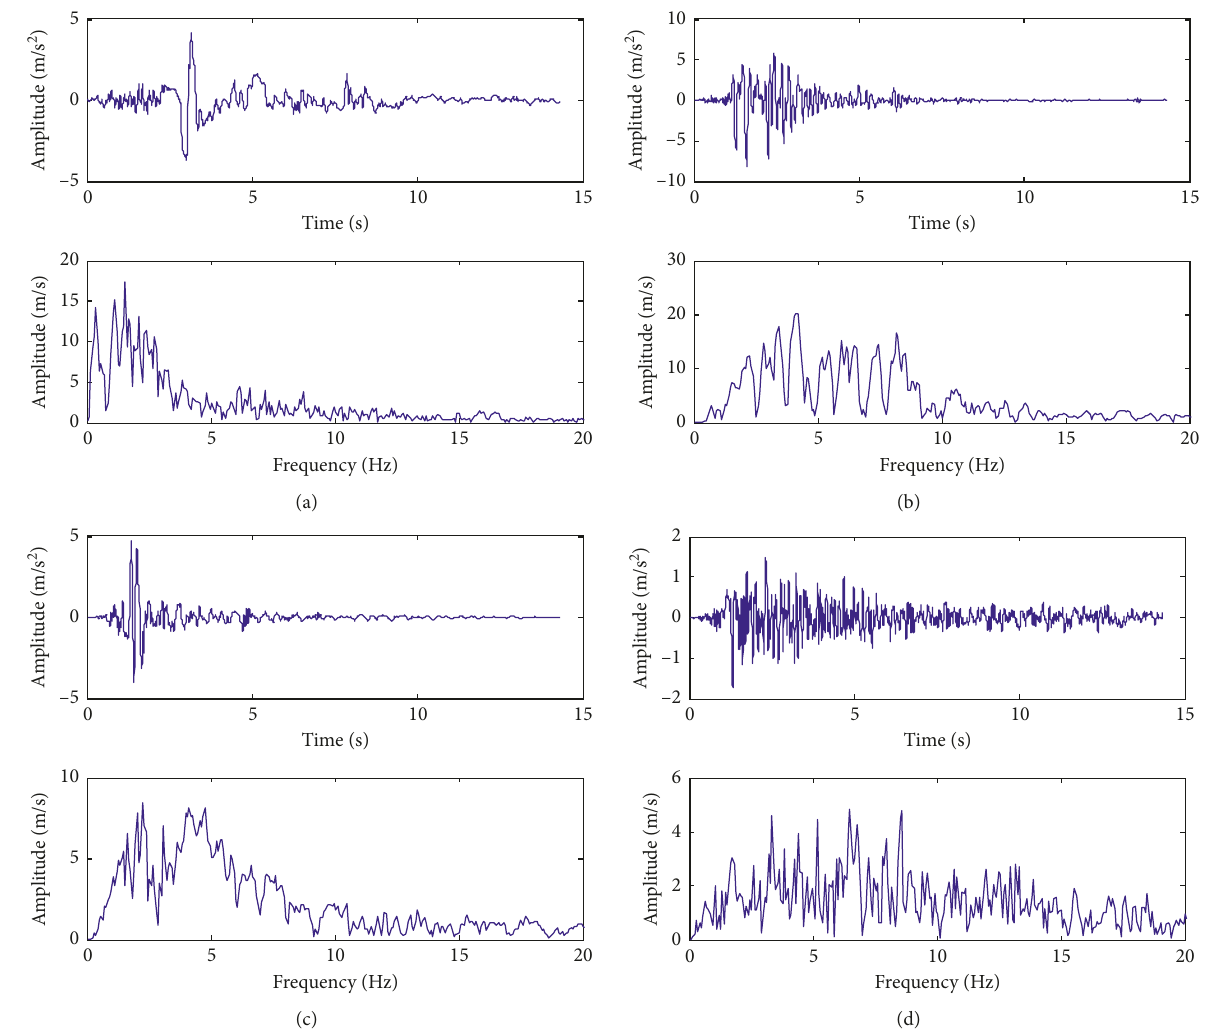
Figure 25: Time histories, and the FFT spectra of strong ground motions. (a) Chichi, (b) Kobe, (c) Parkfield, and (d) Taft.